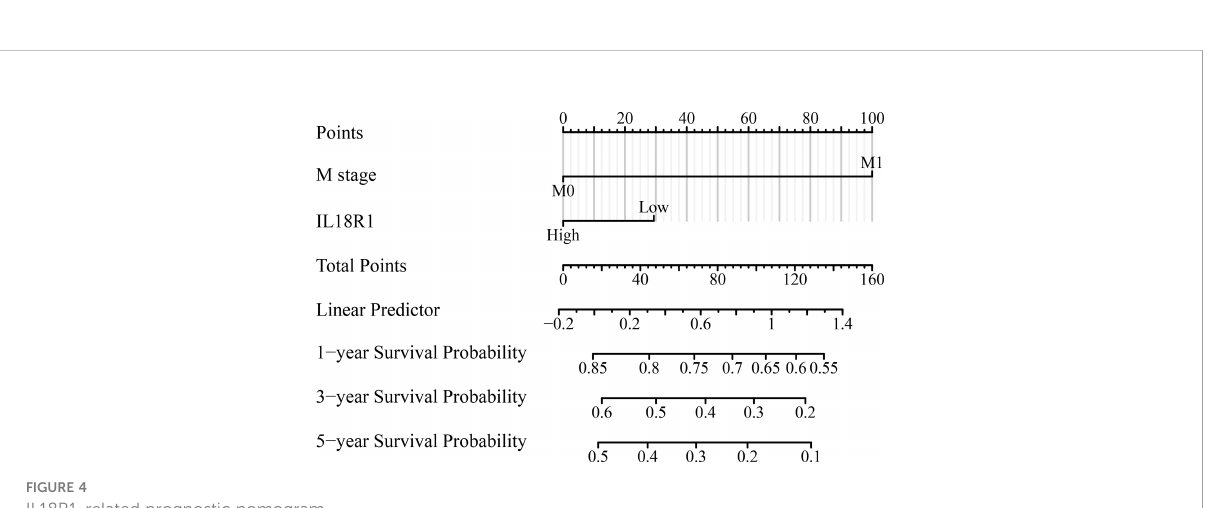
FIGURE 4 IL18R1-related prognostic